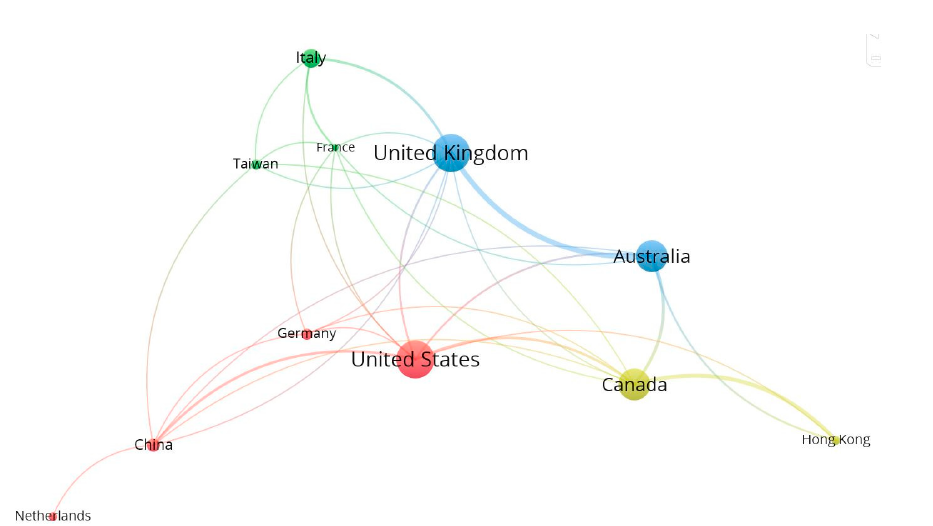
Figure 4. Co-authorship network of countries. Red represents cluster 1, green represents cluster 2, blue represents cluster 3 and yellow represents cluster 4.